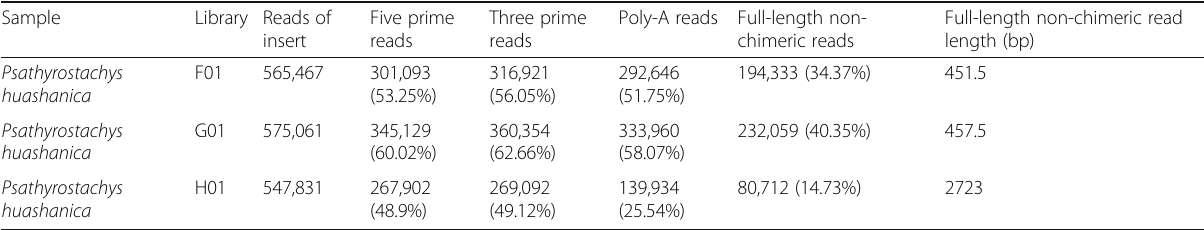
Table 1 Summary of reads of insert (ROIs) classification, the size fraction of F01 and G01 libraries were 1 – 5 kb, and the size fraction of H01 library was 4.5-10